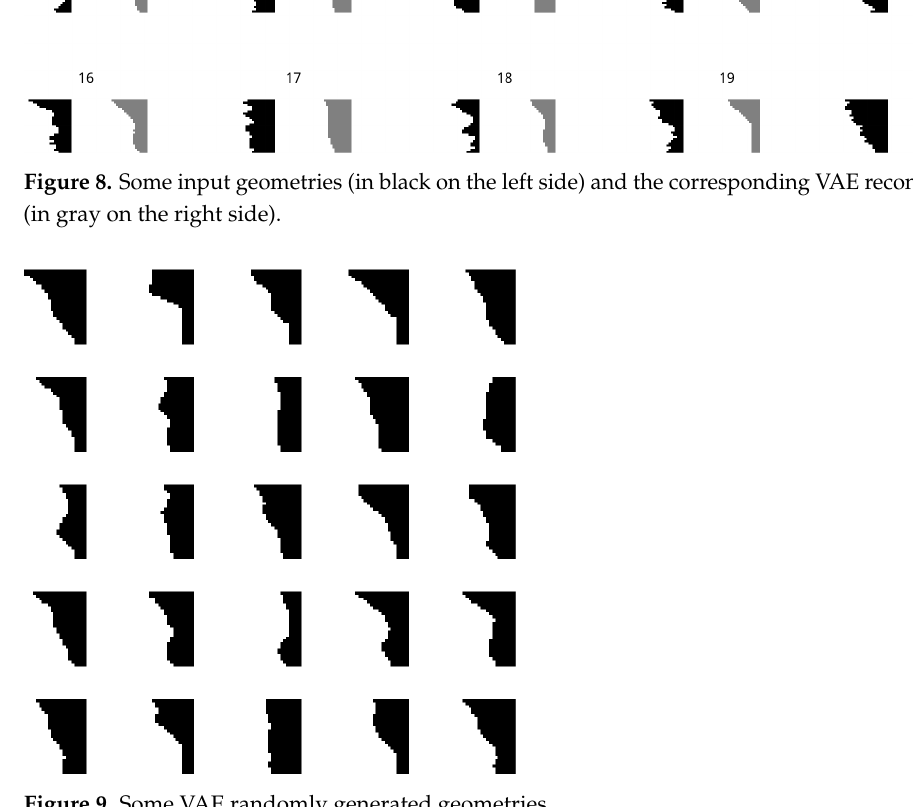
Figure 9. Some VAE randomly generated